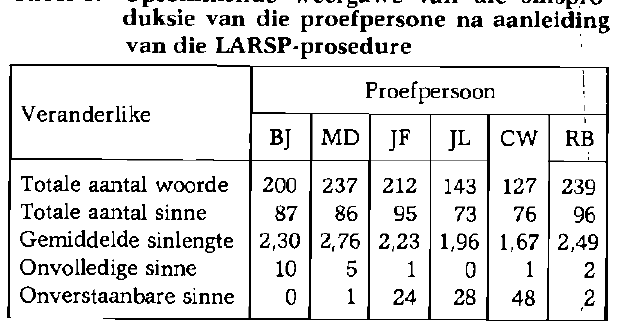
Tabel 6: Opsommende weergawe van die